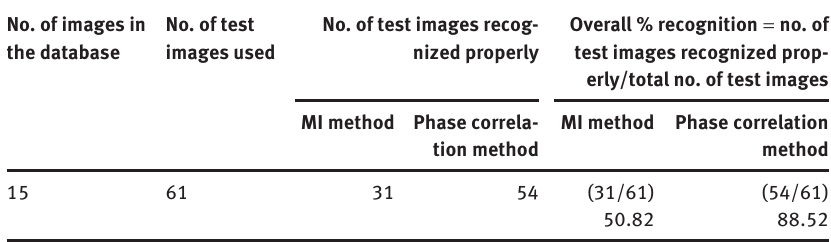
Table 1. Comparison of Results of Moment Invariance (MI) [26] and Phase Correlation